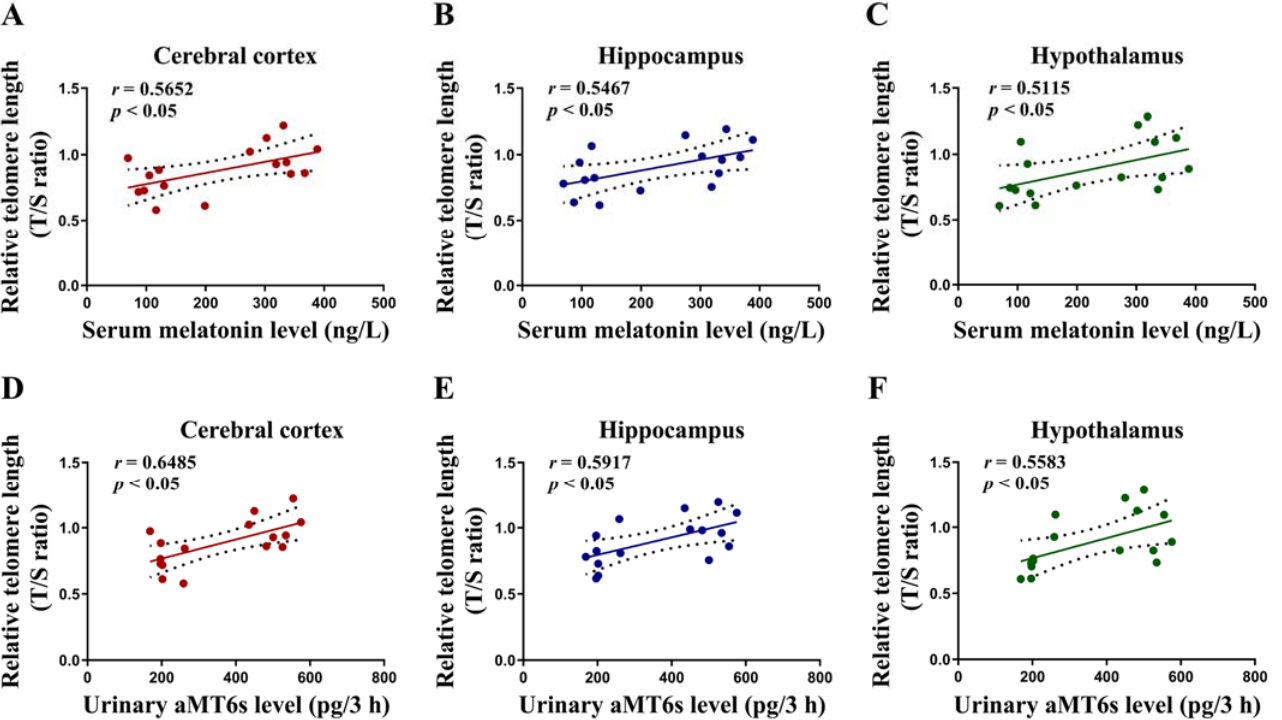
Figure 6. Correlations of serum melatonin and urinary aMT6s level with cerebral telomere length in rats. The serum levels of melatonin were positively correlated with telomere length in cerebral cortex ( r = 0.5652, p < 0.05), hippocampus ( r = 0.5467, p < 0.05) and hypothalamus ( r = 0.5115, p < 0.05) ( A – C ), and the urinary levels of aMT6s were positively correlated with telomere length in cerebral cortex ( r = 0.6485, p < 0.05), hippocampus ( r = 0.5917, p < 0.05) and hypothalamus ( r = 0.5583, p < 0.05) ( D – F